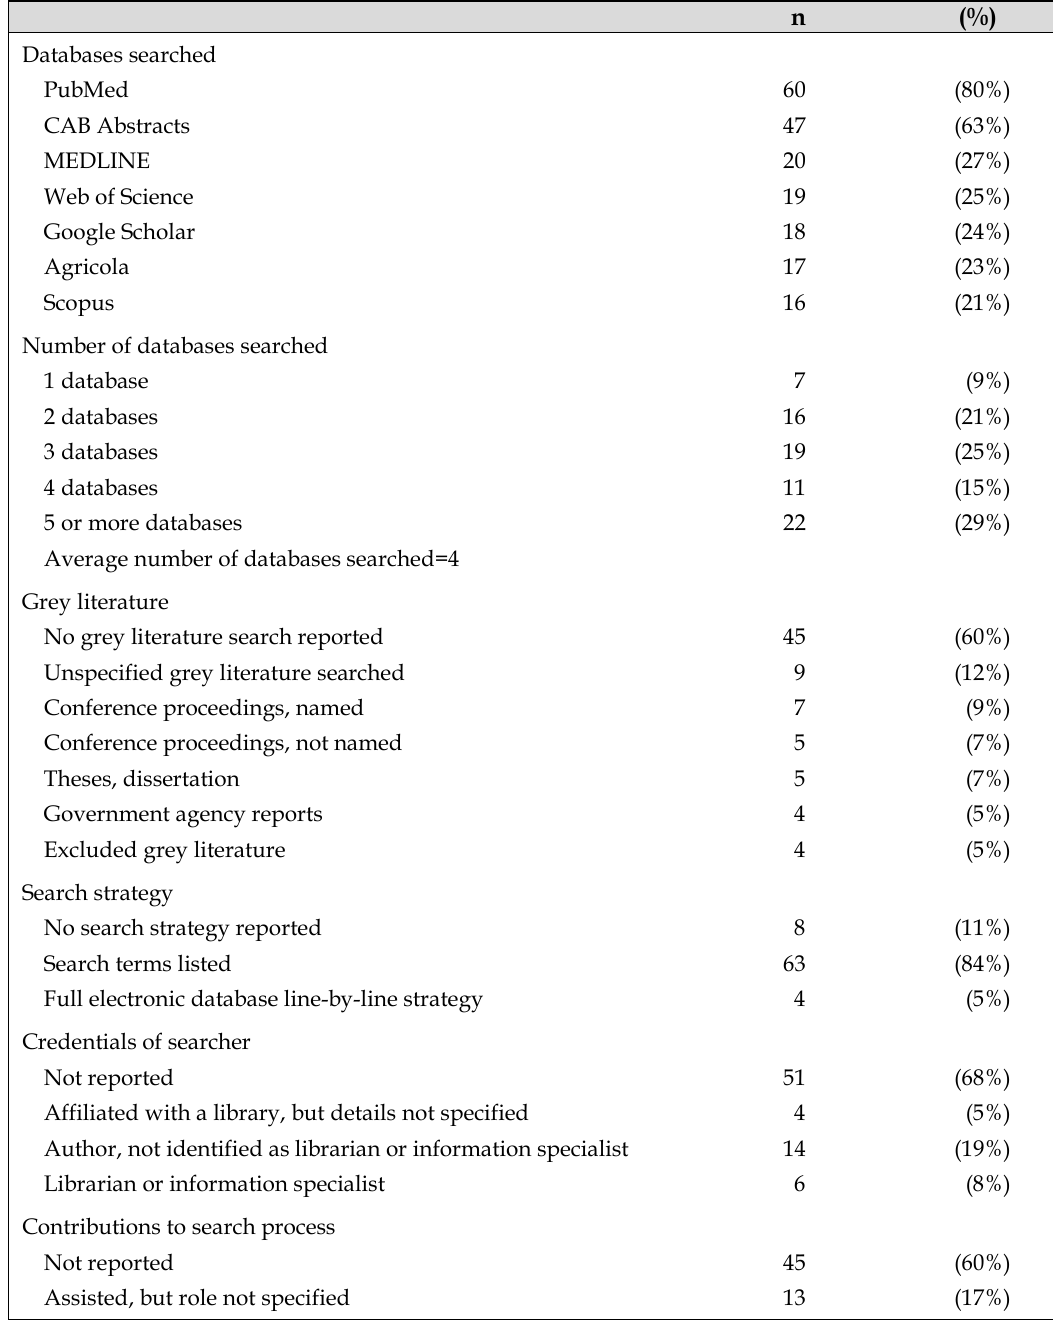
Table 1 Literature search reporting characteristics, systematic reviews sample